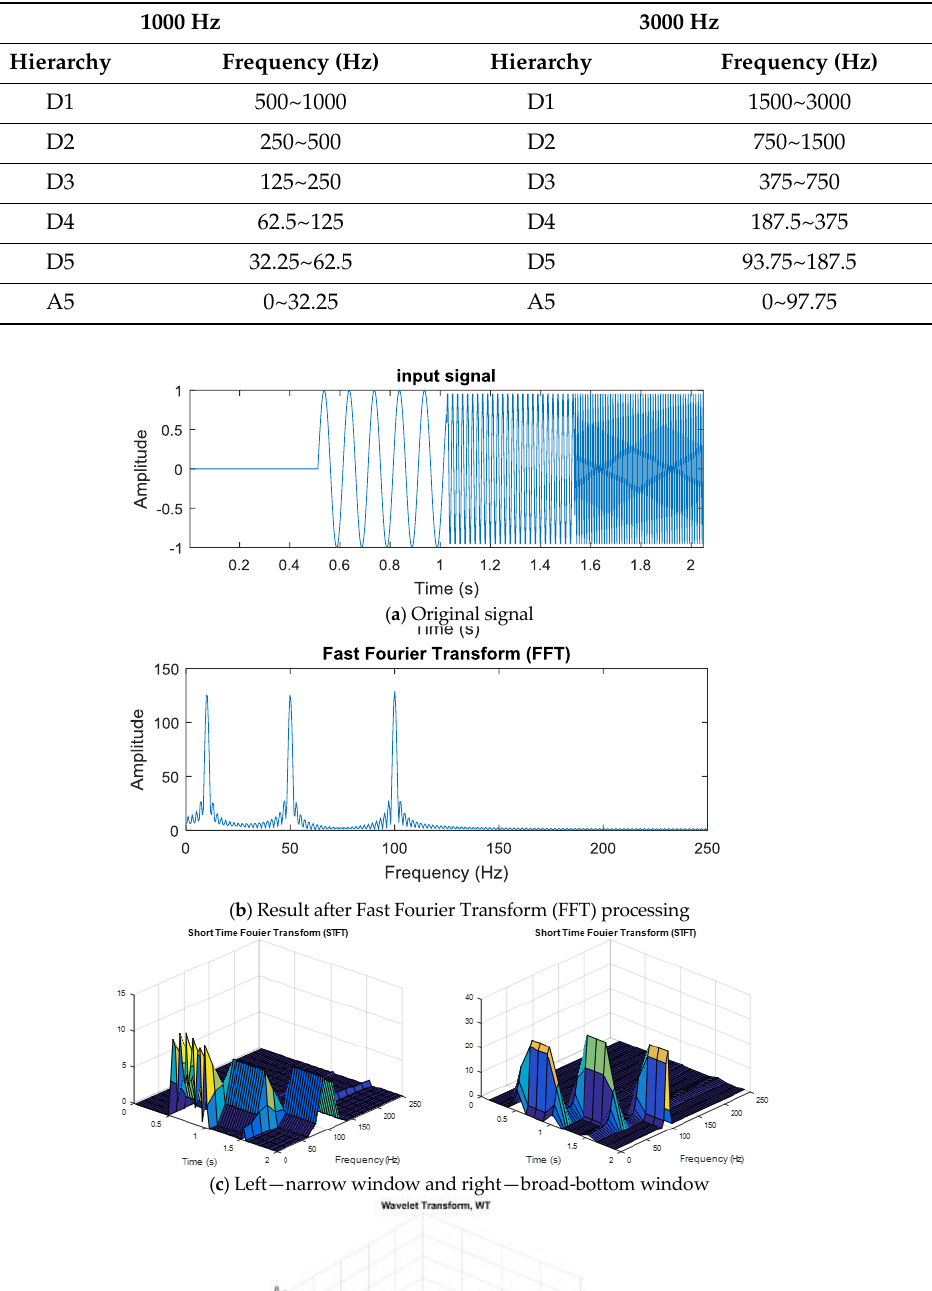
Table 2. The db4 motor frequency bands in respondence.